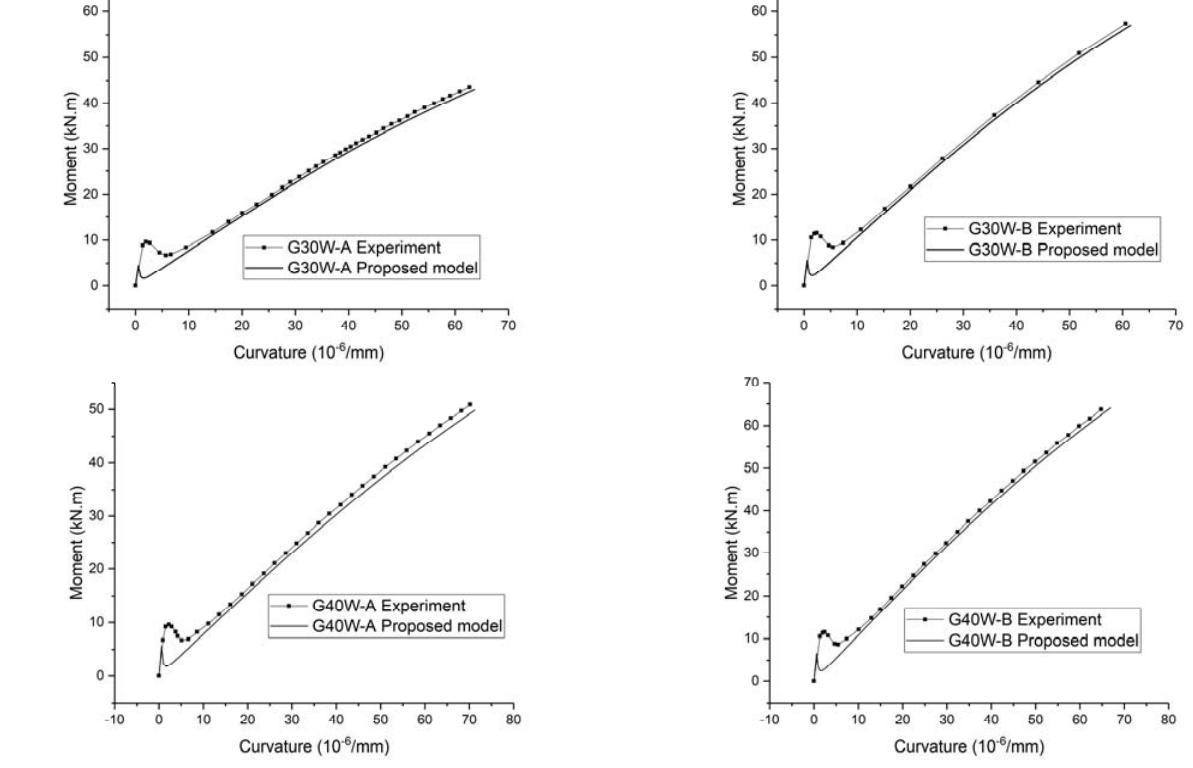
Figure 17. Comparison of present model with moment–curvature tests according to [32].